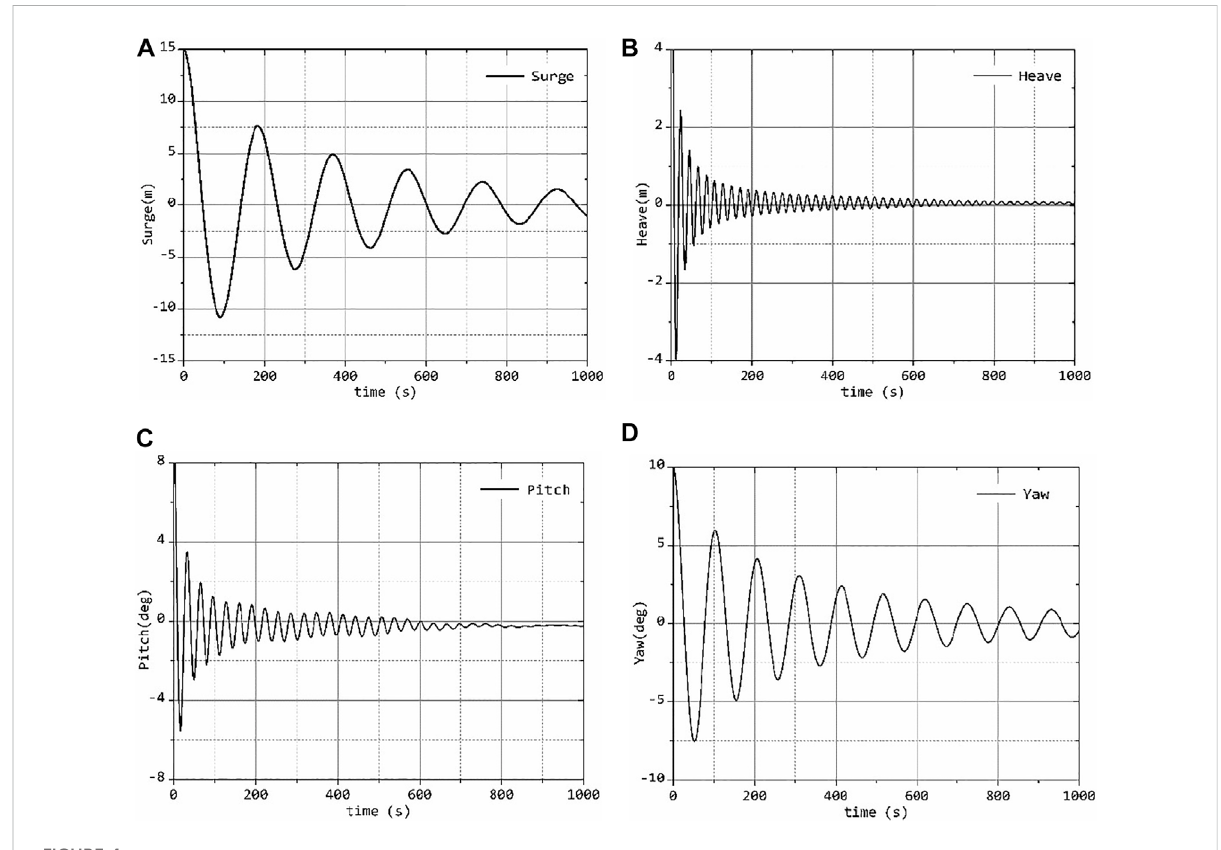
FIGURE 4 The free decay of the OO-Star platform: (A) Surge; (B) Heave; (C) pitch; (D) Yaw.